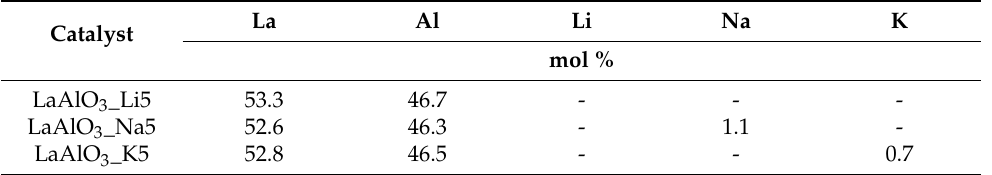
Table 2. Chemical composition of LaAlO 3 _X5 (X = Li, Na, K) catalysts.